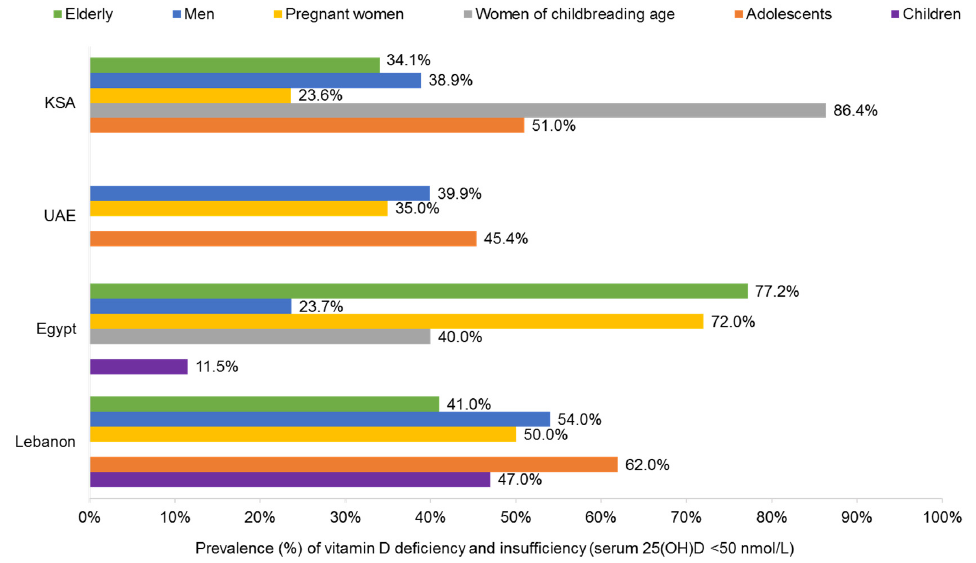
Figure 1. Prevalence of vitamin D deficiency and insufficiency (serum 25(OH)D < 50 nmol/L) in the Middle East by age and gender (Sources: KSA [11,24,40,48]; UAE [20,30]; Lebanon [18,34]; Egypt